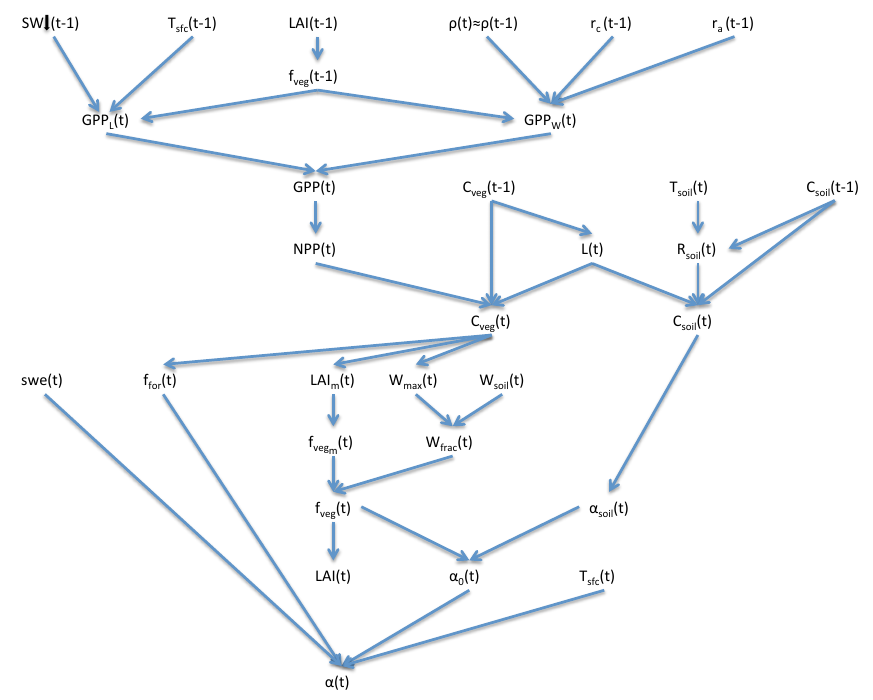
Figure 1. Variable dependencies and updating in